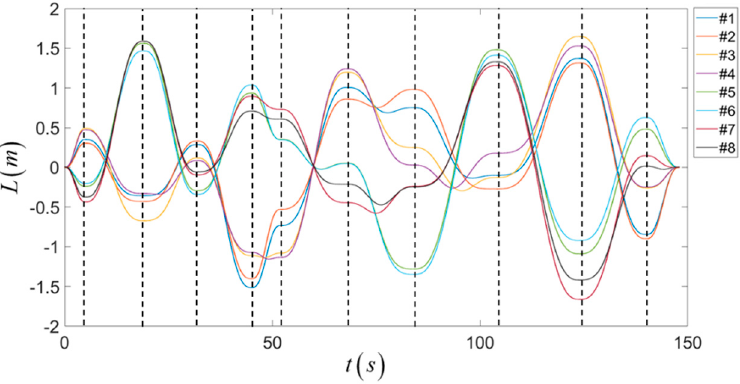
Figure 25. Amplified signals are taken from load-cells while the moving platform moves point-to-point with the linear trajectory.